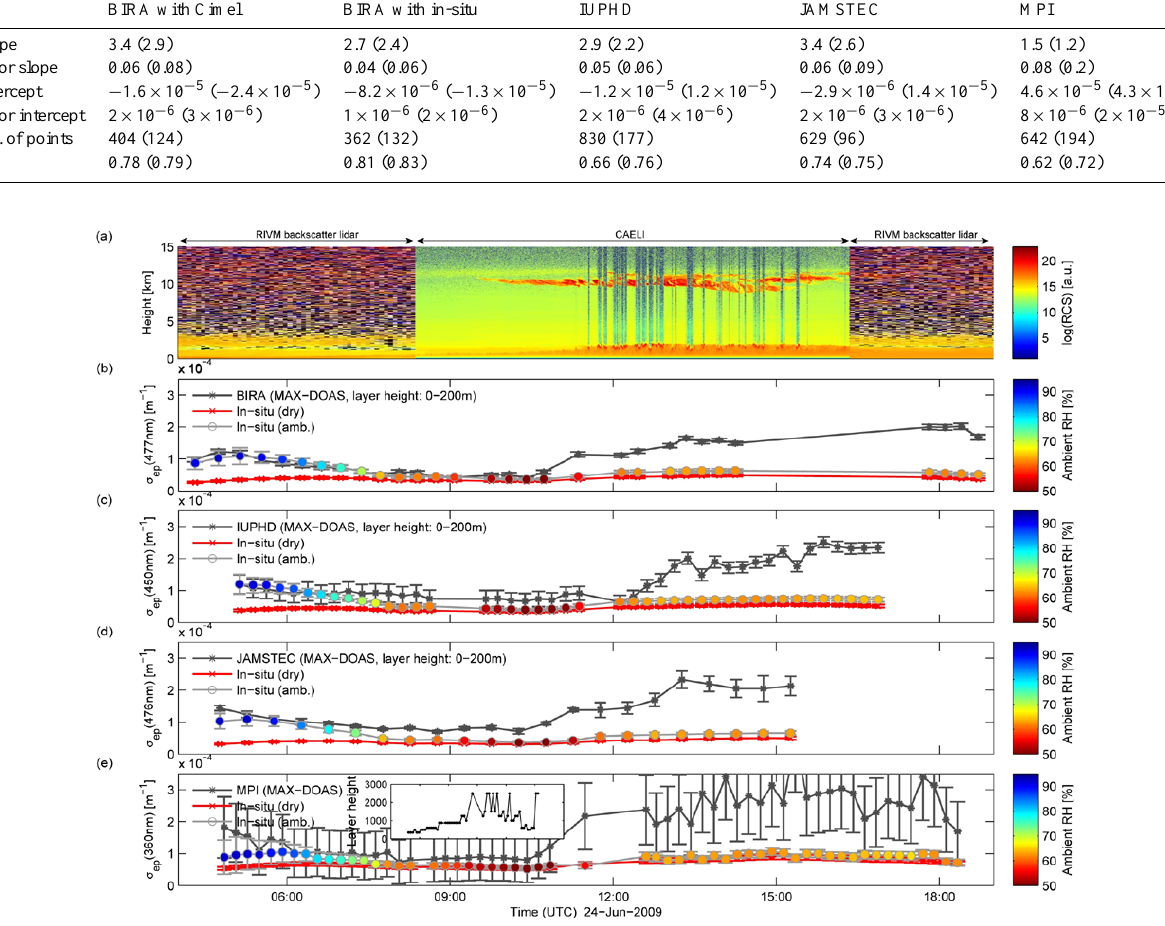
Fig. 7. Example day 24 June 2009 (golden day). Panel (a) Range corrected signal (RCS) at 1064nm measured by the RIVM backscatter and the CAELI LIDAR. Panels (b) – (e) Time series of the aerosol extinction coefficient retrieved by MAX-DOAS instruments (black line) compared to in-situ measurements (red line: dry in-situ extinction coefficient, grey line: ambient value at the RH denoted in the color coded